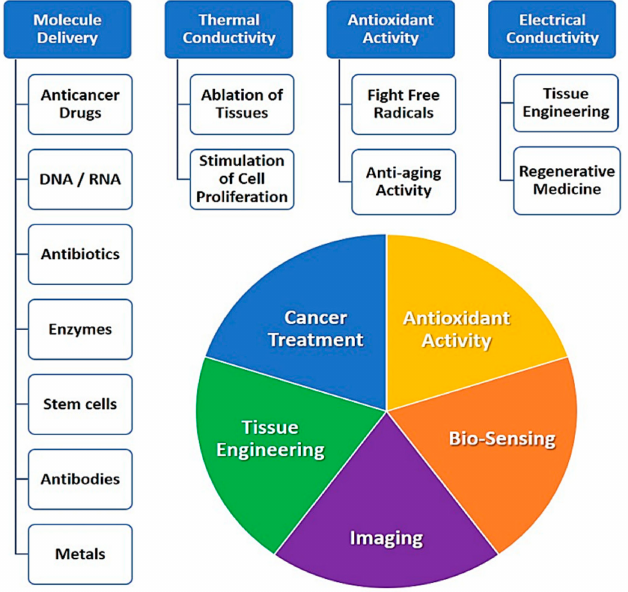
Figure 1. Scheme of main bio-medical applications of carbon